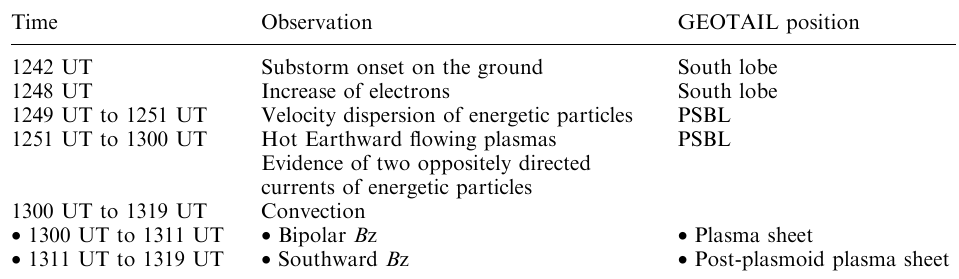
Table 3. The sequence of events as determined from the analysis of GEOTAIL data for the flux rope signature centred at 1307 UT on March 31,